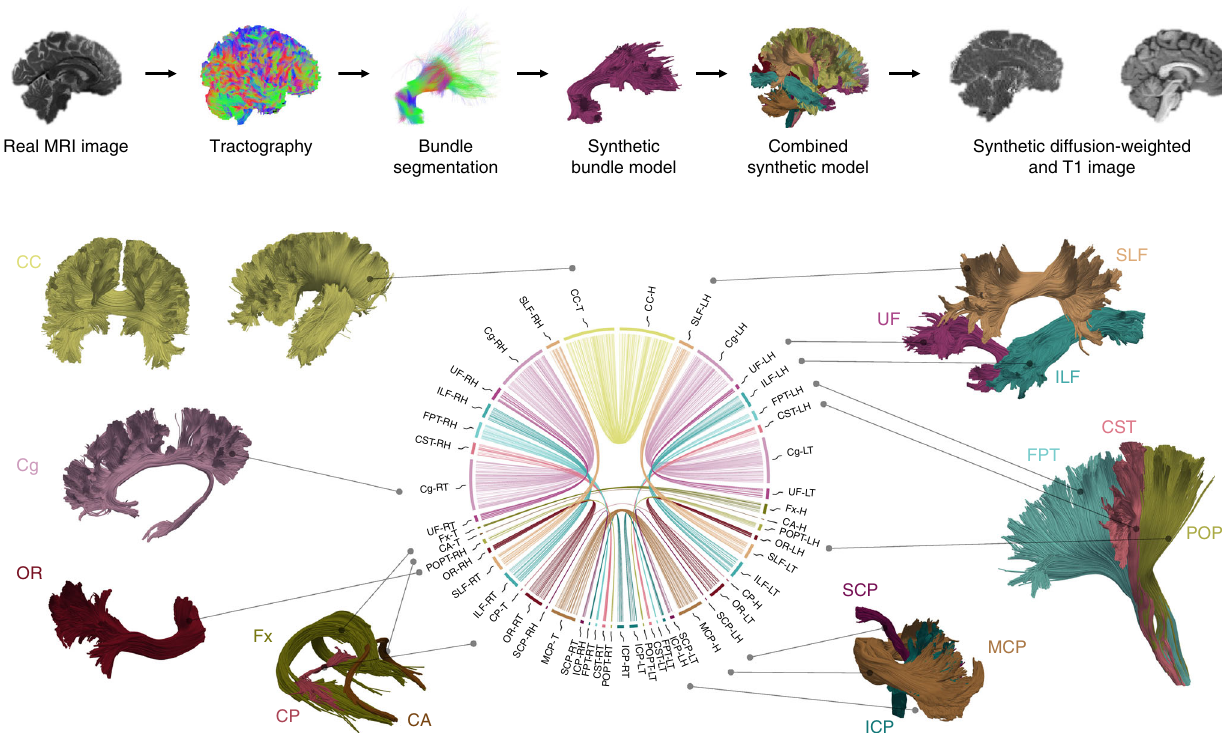
Fig. 1 Overview of synthetic data set. The top row summarizes the phantom generation process. The simulated images are generated from 25 major bundles, which are shown in the bottom part of the fi gure. These were manually segmented from a whole-brain tractogram of a HCP subject and include the CC, cingulum (Cg), fornix (Fx), anterior commissure (CA), optic radiation (OR), posterior commissure (CP), inferior cerebellar peduncle (ICP), middle cerebellar peduncle (MCP), superior cerebellar peduncle (SCP), parieto-occipital pontine tract (POPT), cortico-spinal tract (CST), frontopontine tracts (FPT), ILF, UF, and SLF. The connectivity plot in the middle shows the phantom design. The segment positions correspond to the involved endpoint region (from top to bottom: frontal lobe, temporal lobe, parietal lobe, occipital lobe, subcortical region, cerebellum, brain stem). The radial segment length and the connection number in the plot are chosen according to the volume of the respective bundle endpoint region. Abbreviations: right (R) and left (L) hemisphere, head (H) and tail (T) of each respective